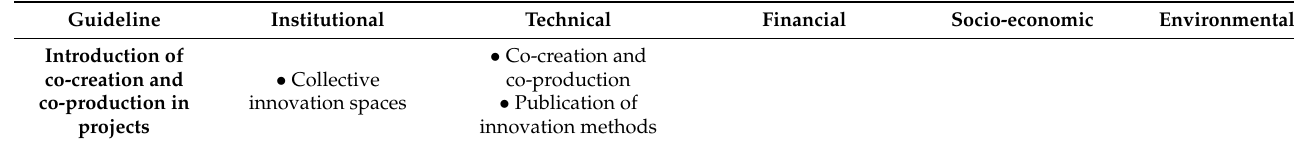
Table 4. Guidelines for electrification projects (PV